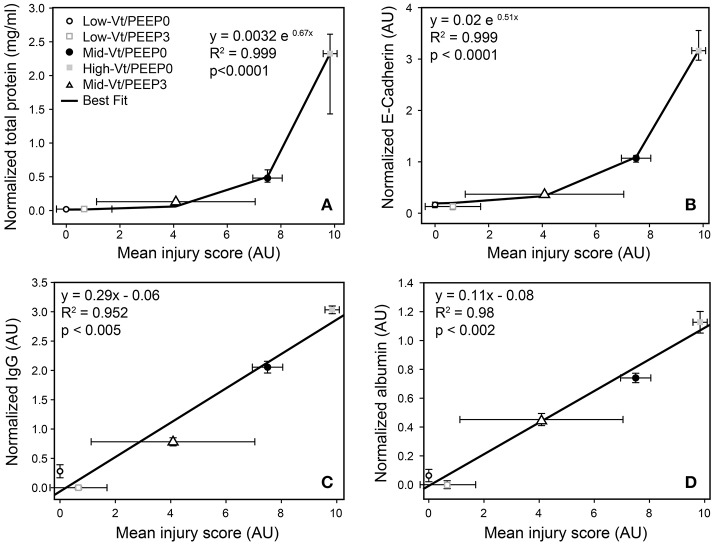
Correlation between injury scores obtained from histological evaluation and total protein (A), normalized E-Cadherin (B), normalized IgG-HC (C), and normalized serum albumin (D). Normalized total protein and E-Cadherin show the median and interquartile range; all other data are mean and standard deviation.